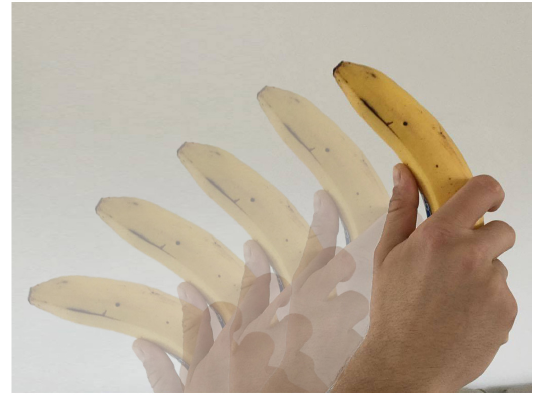
Figure 2. Example of palinopsia. An example of a moving object (the hand is moving from left to right) with perseverance of multiple images is shown.